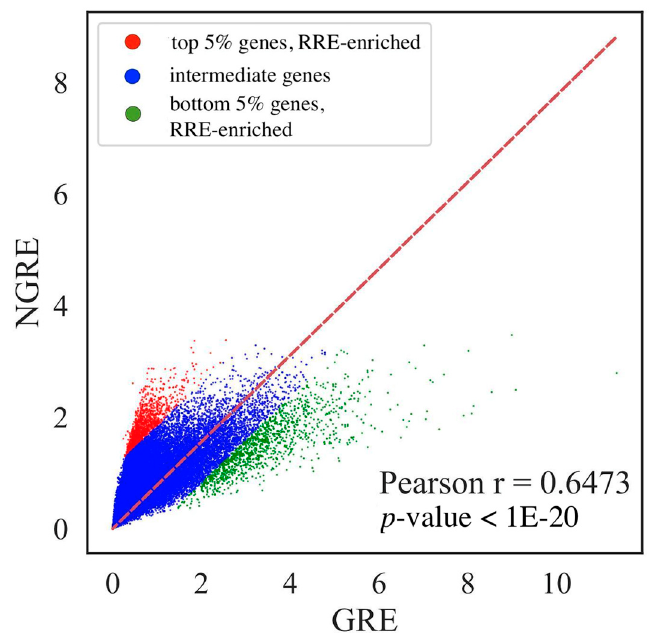
Figure 3. Comparison of GRE (abscissa axis) and NGRE (axis of ordinates) scores for human genes. Color indicates different gene groups (red—RRE-enriched genes, blue—intermediate genes, green—RRE-deficient genes). Each dot represents single gene. Pearson correlation coefficient (r) and Pearson p -value ( p ) are shown separately.